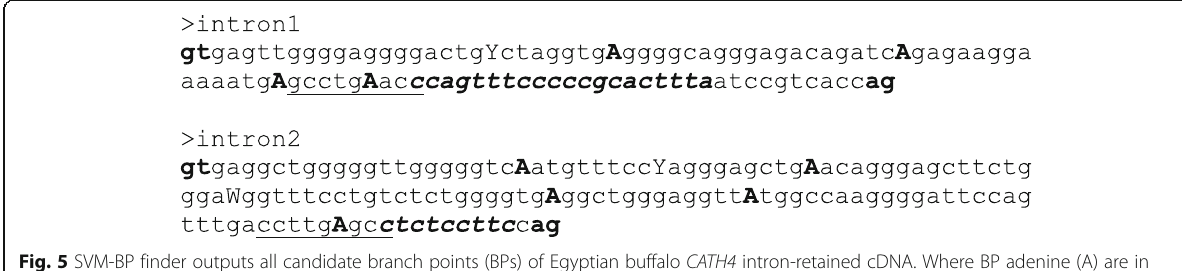
Fig. 5 SVM-BP finder outputs all candidate branch points (BPs) of Egyptian buffalo CATH4 intron-retained cDNA. Where BP adenine (A) are in capital letters, BP sequence (nonamer; from − 5 to +3 relative to the BP adenine) are underlined, and polypyrimidine tract length (ppt_len) are